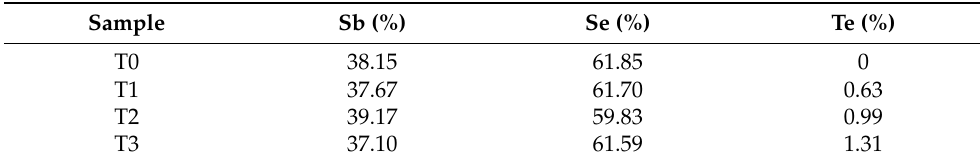
Table 2. Elemental composition of the Sb 2 Se 3 thin films deposited at the different doping condition (Te weight).